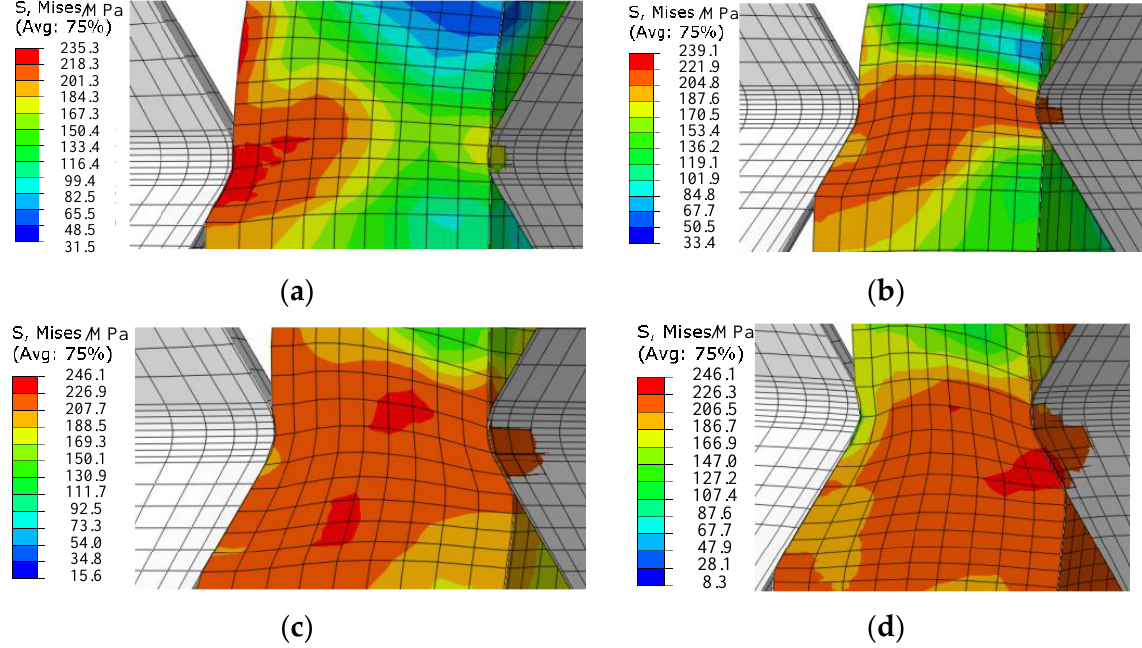
Figure 16. The stress nephograms of the tube deformation region with different thickness reduction in ACRFF processes: ( a ) 10%; ( b ) 20%; ( c ) 30%; ( d ) 35%.